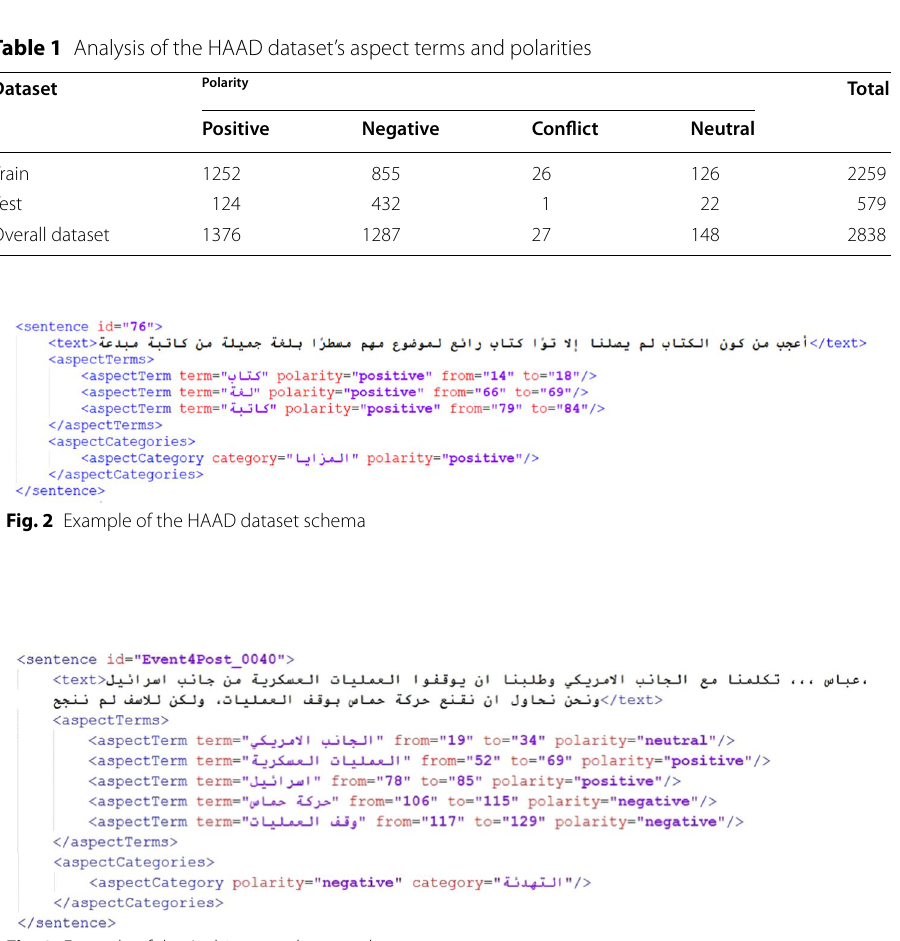
Fig. 3 Example of the Arabic news dataset